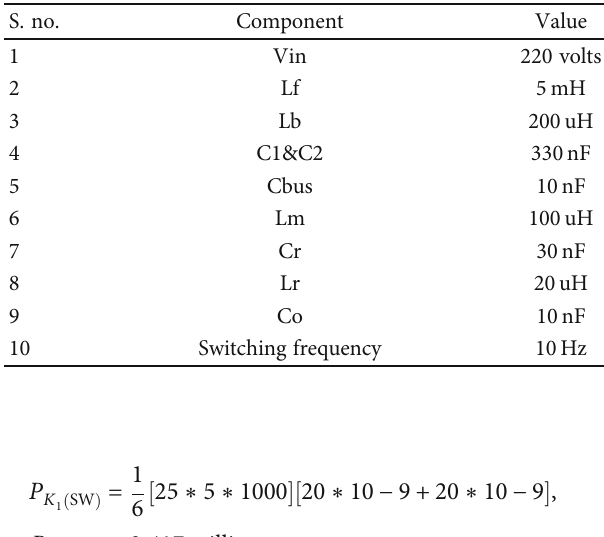
Table 3: Circuit component values used in simulation and experimental setup.